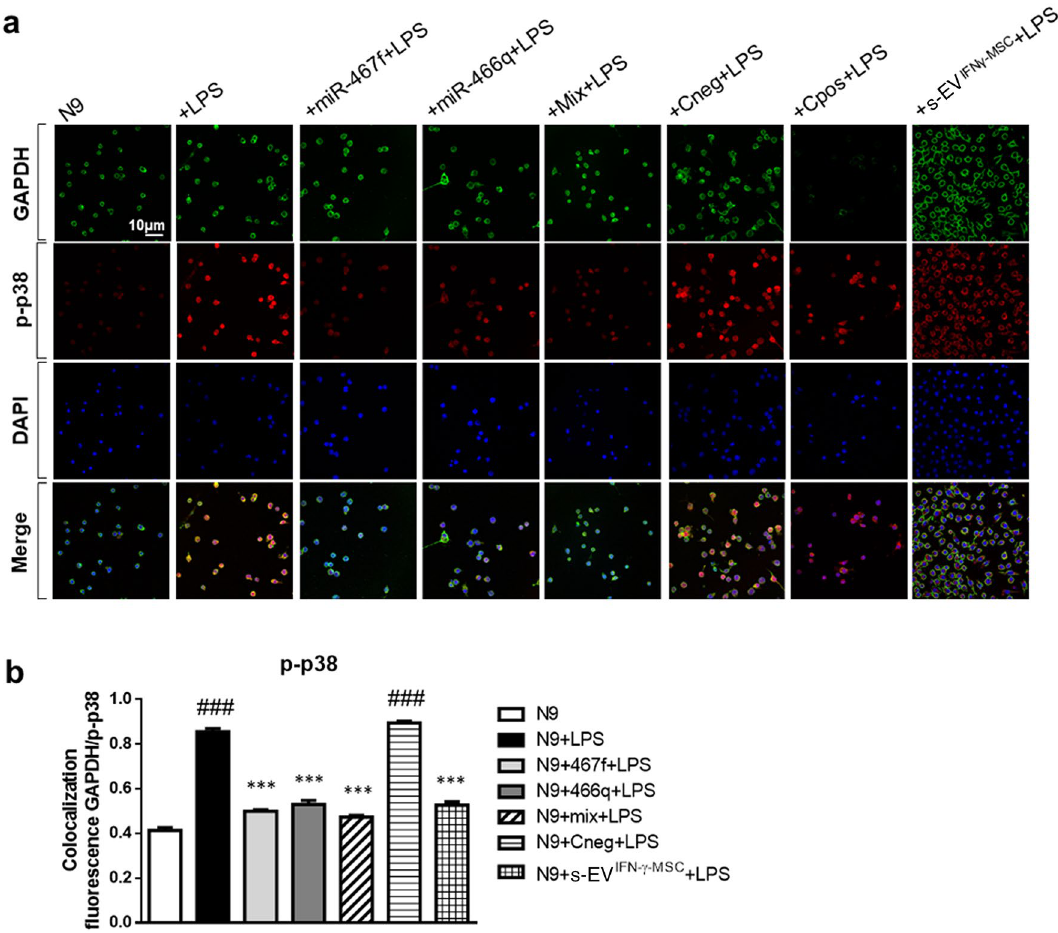
Figure 5. Activation of p38 MAPK signaling pathway in pro-inflammatory microglia is reverted by transfection with miR-467f and miR-466q or by exposure of the cells to s-EV IFN-γ-MSC . Representative images ( a ) and quantification ( b ) of immunofluorescence analysis indicated that transfection with miR-467f and miR-466q, alone or with a mixture of both (N9 + Mix + LPS), or exposure to s-EV IFN-γ-MSC reverted the over- phosphorylation of p38 in LPS-activated N9 cells to that of non-activated N9 cells. ### P < 0.0001, N9 vs N9 + LPS or LPS-activated N9 transfected with Cneg (N9 + Cneg + LPS); *** P < 0.0001, N9 + LPS vs N9 + LPS transfected with specific miRNA (N9 + miRNA + LPS or N9 + Mix + LPS) or treated with s-EV (N9 + s-EV IFN-γ-MSC + LPS). Data are presented as mean ± SEM of 3 independent experiments conducted in